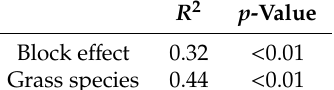
Table 1. The effects of grass species on rhizosphere microbiome composition. Permutational Table1. Thee ff ectsofgrassspeciesonrhizospheremicrobiomecomposition. Permutationalmultivariate multivariate analyses of variance (PERMANOVA) analysis was performed using Bray–Curtis analyses of variance (PERMANOVA) analysis was performed using Bray–Curtis distance to indicate distance to indicate microbial composition. The block effect in the randomised complete block design microbial composition. The block e ff ect in the randomised complete block design was included was included and tested. and tested.